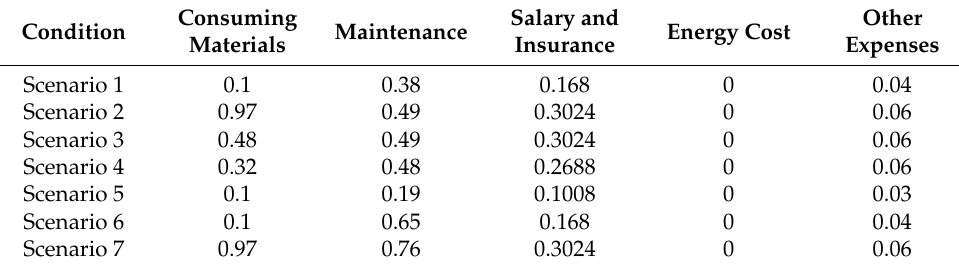
Table 13. Operating and utilizing costs for different scenarios of an anaerobic digester design (million